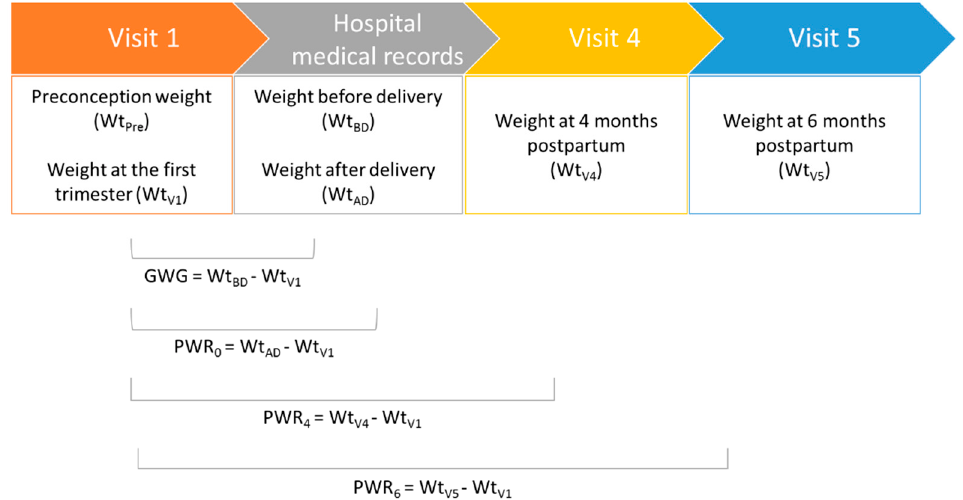
Figure 1. Timeline of anthropometric data collection.